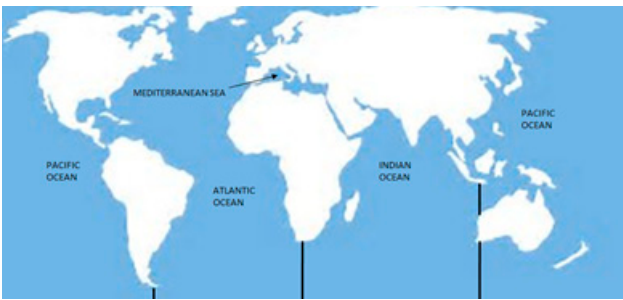
Figure 1. Approximate Ocean regions used in the four region S-DSM model.